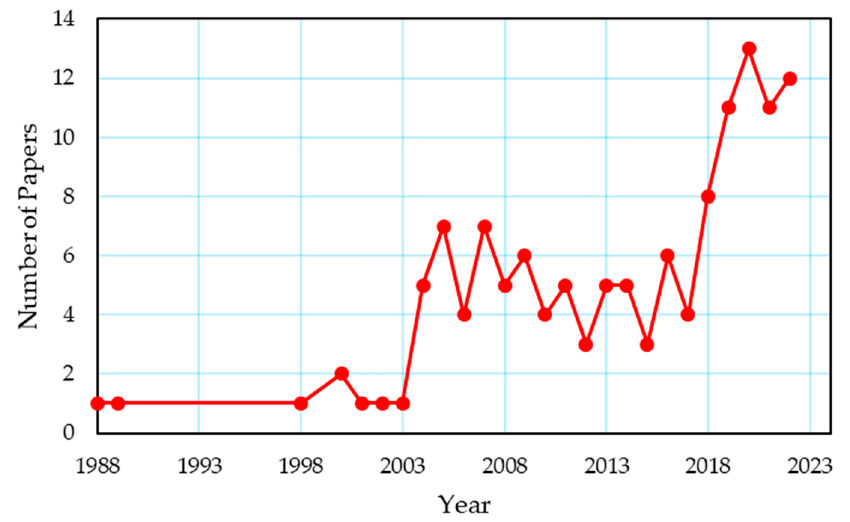
Figure 1. Yearly distribution of studies on the thermal management of a metal hydride hydrogen tank coupled with a fuel cell and/or an tank coupled with a fuel cell and/or an electrolyzer.